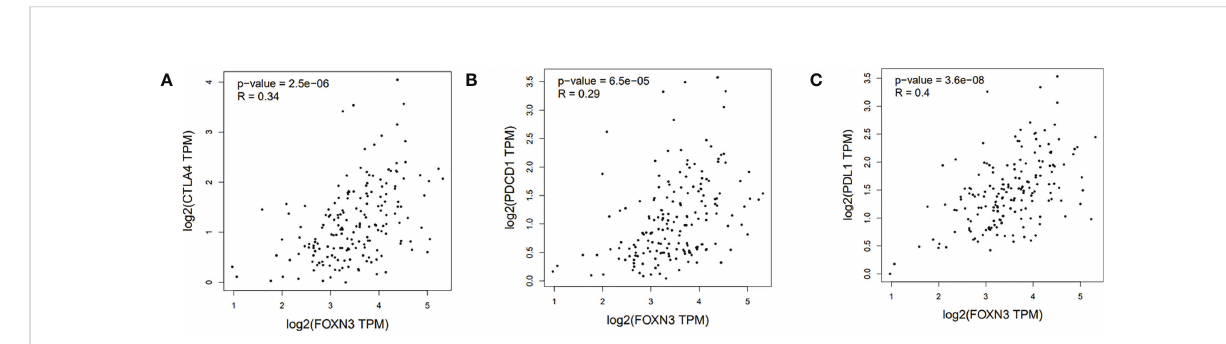
FIGURE 10 (A) Correlation between FOXN3 and CTLA4 in PDAC patients in TCGA database. (B) Correlation between FOXN3 and PDCD1 in PDAC patients in TCGA database. (C) Correlation between FOXN3 and PDL1 in PDAC patients in TCGA